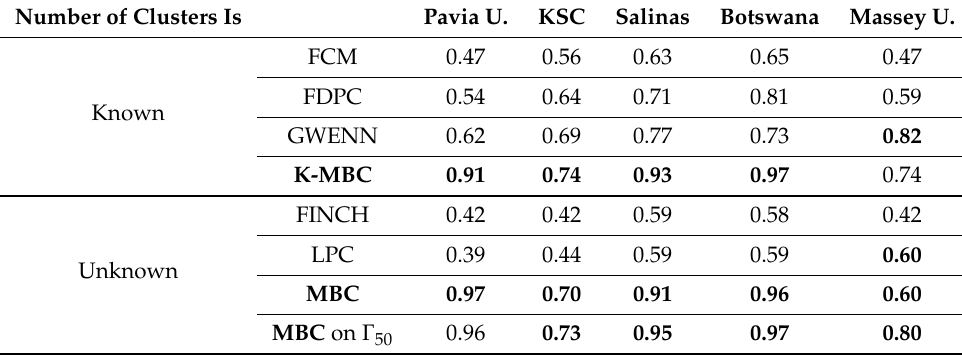
Table 5. Comparison of clustering results: Purity (higher is better, max: 1). Number of Clusters Is Pavia U.